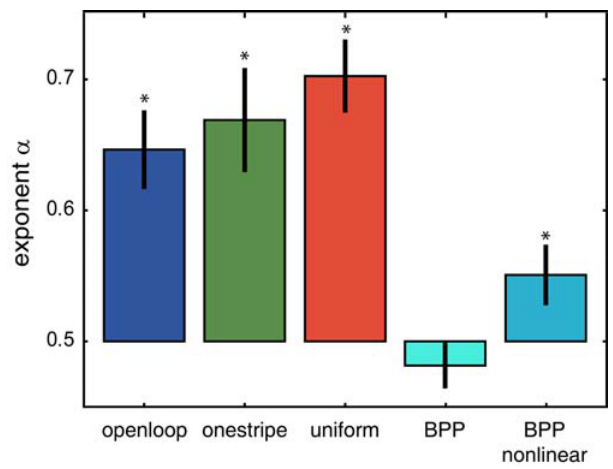
Figure 5. Long-range correlations in fly ISIs. If the slope of the log-log plots of the r.m.s. fluctuation (exponent a , see Methods ) deviates significantly from K , long-range correlations exist in the time series. All three fly groups show a significant deviation from 0.5. The deviation of branched Poisson processes ( BPP ), however, depends on the non- linearity of the filter function used to drive the Poisson processes and is significantly smaller than that of fly ISI series. *-significant difference from